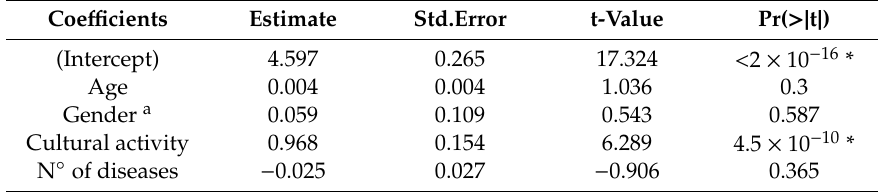
Table 4. Regression models with Resilience as the dependent variable: Model 1b (cultural activity). Coe ffi cients Estimate